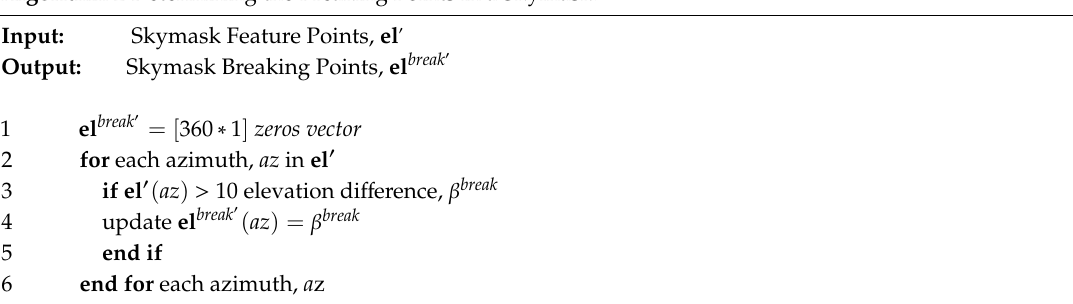
Algorithm 2 Determining the Breaking Points in a